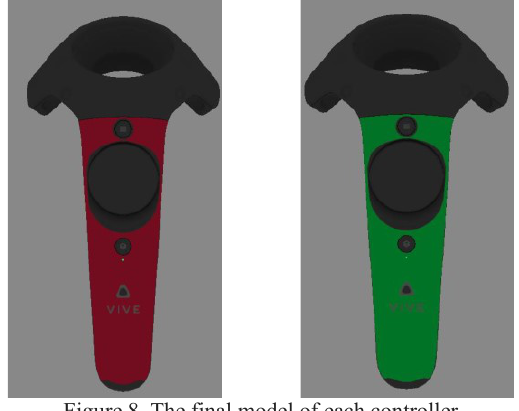
Figure 8. The final model of each controller